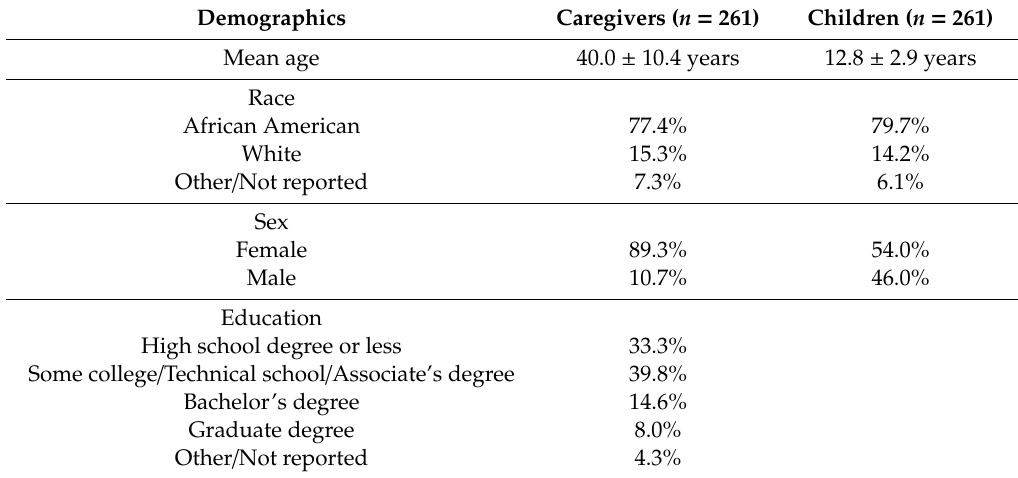
Table 1. Demographics of caregivers and children enrolled in